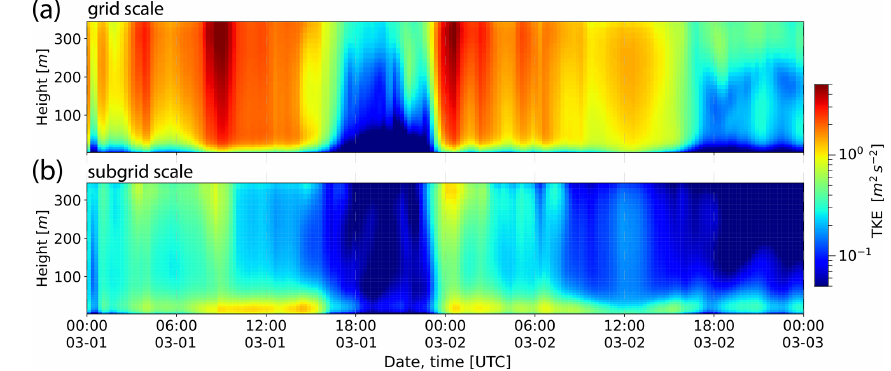
Figure 12. Horizontally averaged vertical distribution of grid-scale and sgs TKE versus time for simulation L0.